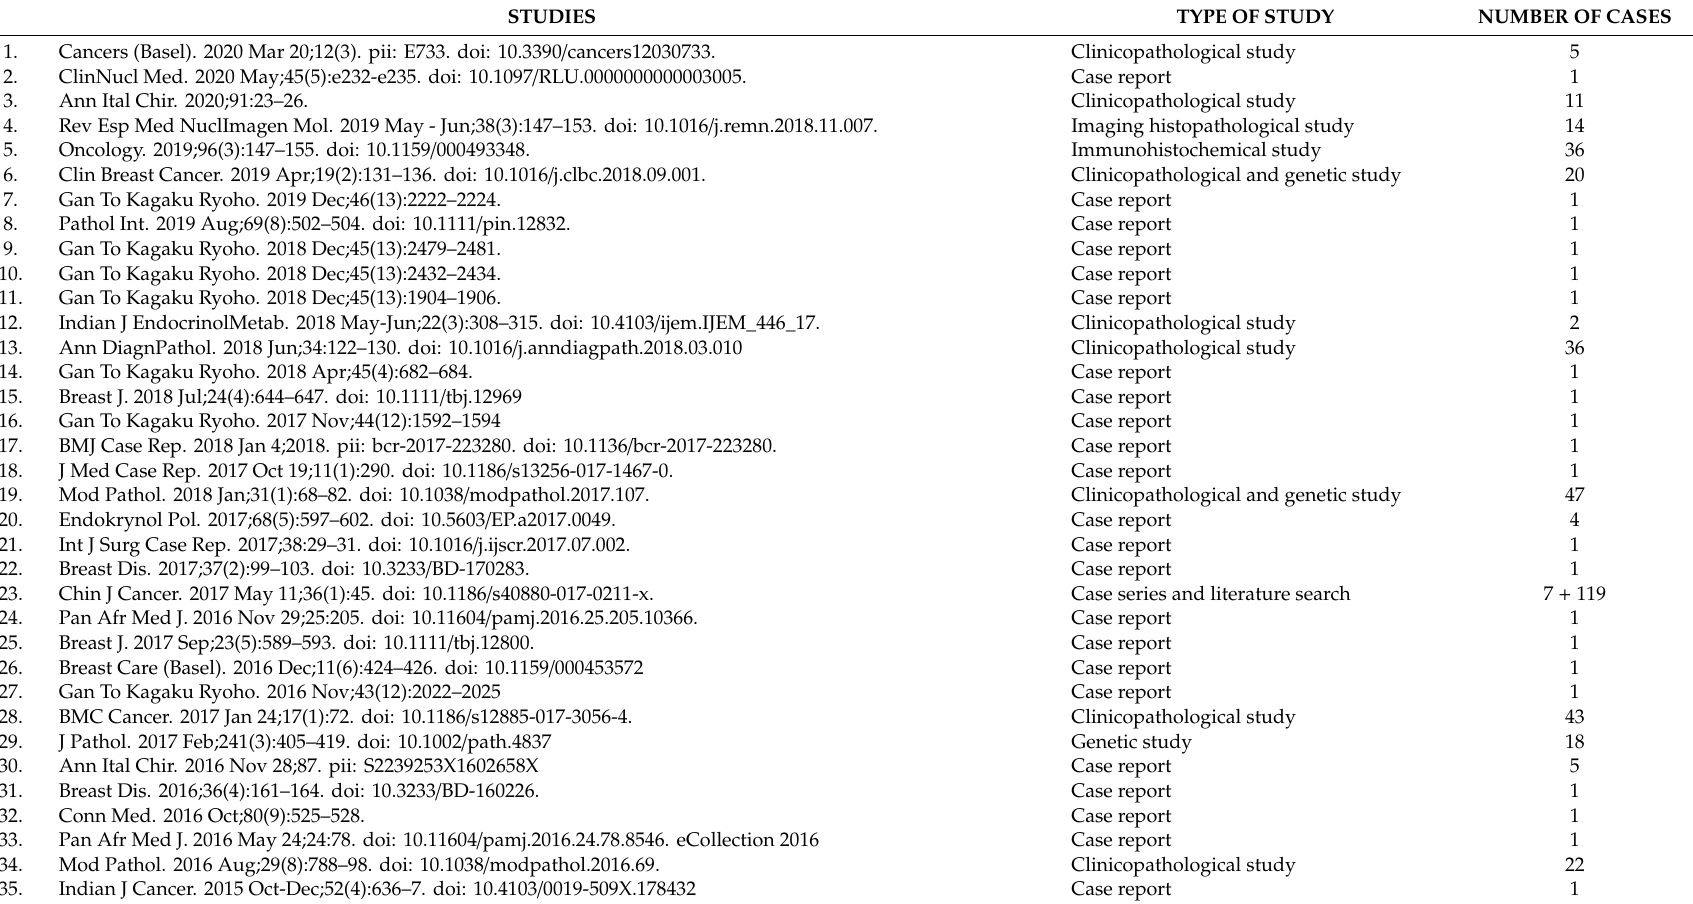
Table A1. The table lists all studies published on PubMed since 2004. It is evident that these are mostly case reports. As illustrated in the text, there are limits relating to the uniformity of the diagnostic criteria up to the most recent WHO definitions. The most numerous studies are mostly retrospective in